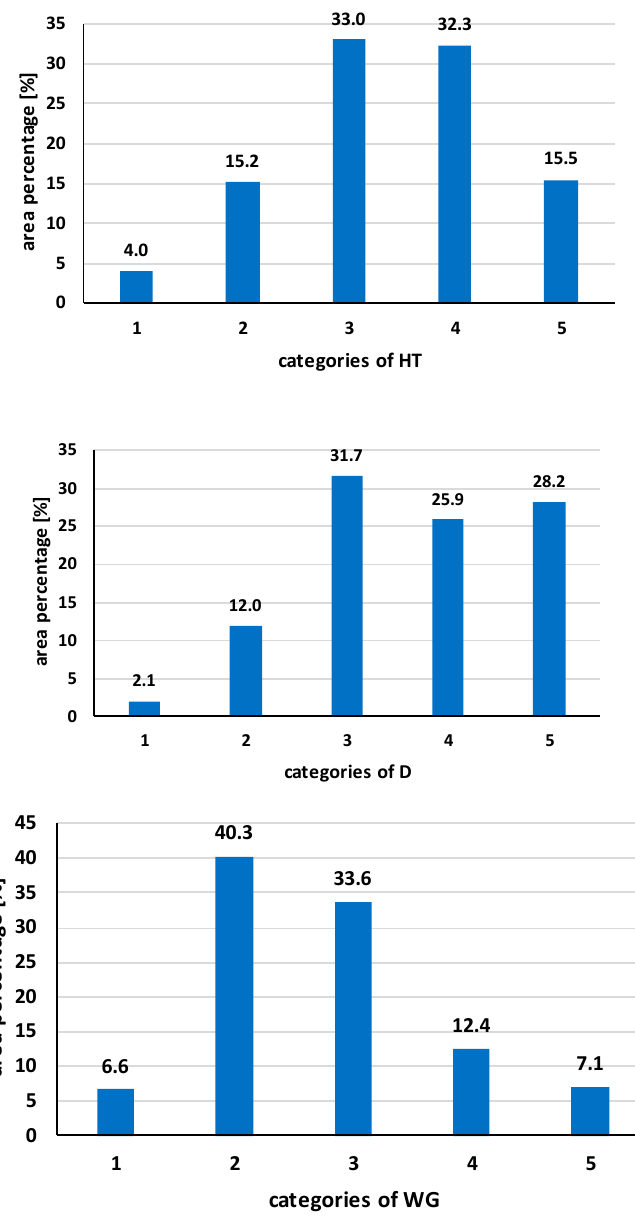
Figure 5. Categories of wind gust (WG) risk based on long-term annual occurrence of wind speeds above 10 m s − 1 (WS10).